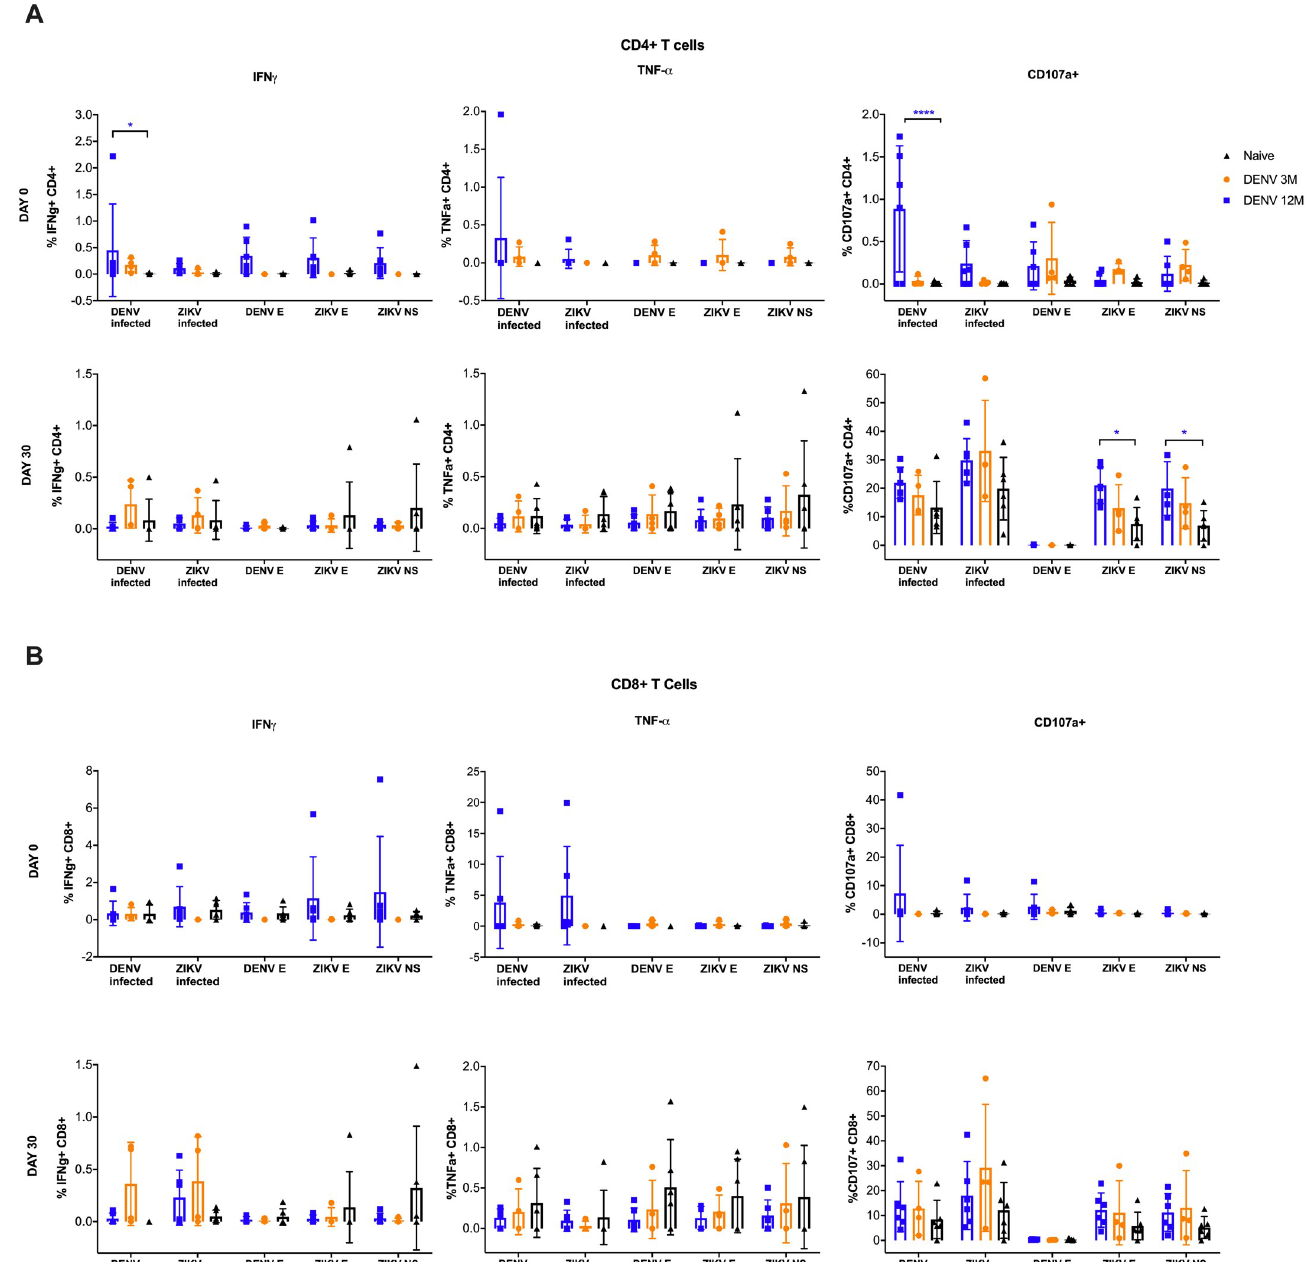
Fig 5. Antigen-specific CD4 + and CD8 + responses prior and after ZIKV infection. The frequency of the specific response to DENV and ZIKV antigens differs among cohorts. In all panels, animals exposed to DENV 12 months before ZIKV infection are in blue, while animals exposed to DENV 3 months before are in orange. Na ï ve animals are in black. All percentages shown are subtracted from the unstimulated background. (A) Analysis of CD4 T cell response to different stimuli before (upper panel) and 30 days after ZIKV infection (lower panel). (B) Analysis of CD8 T cell response to different stimuli before (upper panel) and 30 days after ZIKV infection (lower panel). Statistically significant differences among groups were calculated by two-way ANOVA using Dunnett’s multiple comparisons test ( � P < 0.05 and ���� P < 0.0001). Colored stars represent a significantly different group, while colored lines represent the group that it is compared